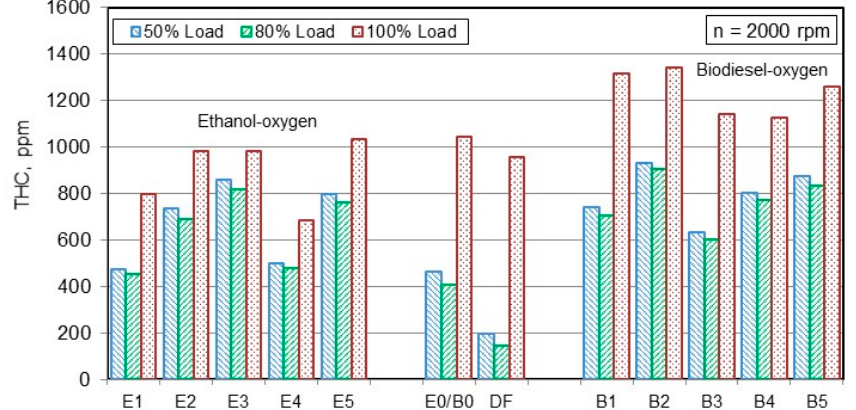
Figure 16. Effect of ethanol–oxygen or biodiesel-oxygen mass content (wt%) in fuel blends on the production of total unburned hydrocarbons (THC) when running under medium (50%), intermediate (80%), and full (100%) loads corresponding to the respective IMEPs of 0.75, 1.20, and 1.50 MPa developed at maximum torque speed of 2000 rpm.